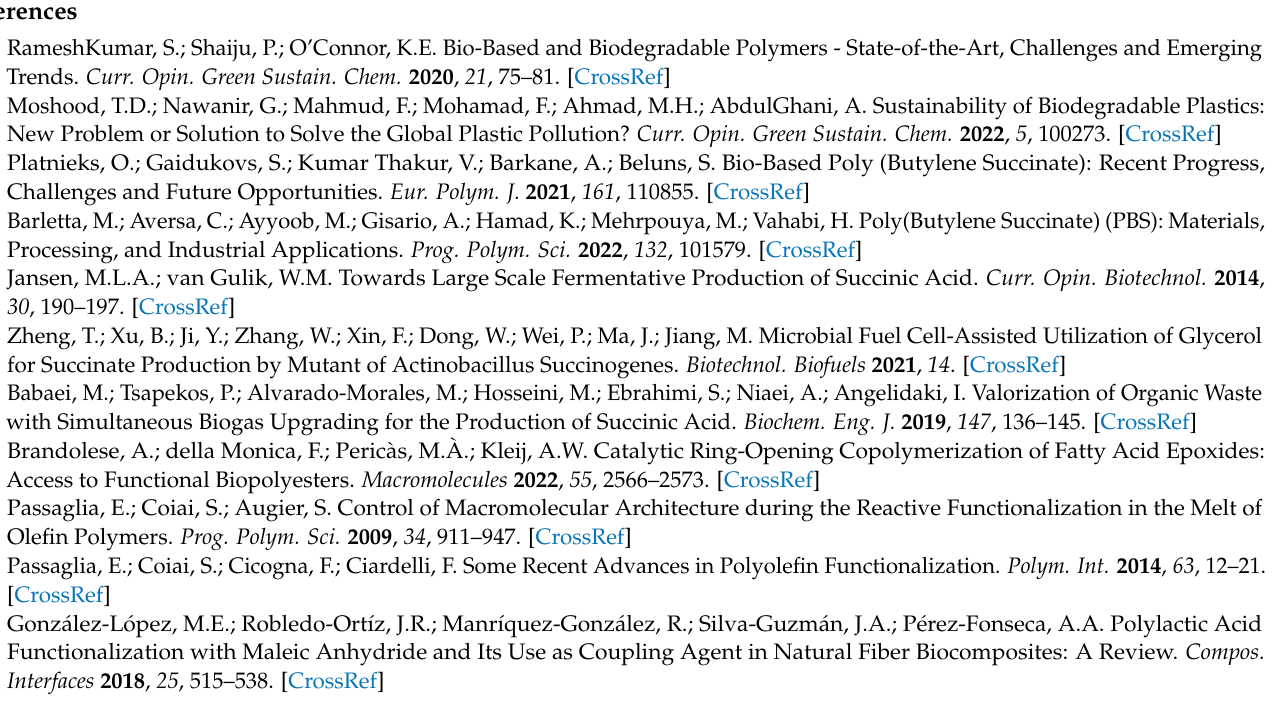
heating (a); crystallization first cooling (b); melting second heating (c), Figure S5: Overlay of SEC curves between 8 and 17 min of PBS (a) and PBS-g-(BHB-T)3 (b) after 0, 2, 4, 5, 6 and 7 h of oven aging. All chromatograms were normalized, Figure S6: Overlay of SEC curves between 8 and 16 min of PBS (a) and PBS-g-(BHB-T)3 (b) after 0, 0.5, and 6 h of UV irradiation. All chromatograms were normalized, Figure S7: Overlay of UV-Vis spectra of β -carotene solution (10 − 5 M) per different irradiation time (0: 0 min; 1: 10 min; 2: 20 min; 3: 30 min; 4: 40 min; 5: 60 min; 6: 90 min; 7: 140 min; 8: 190 min), Figure S8: Overlay of UV-Vis spectra of β -carotene solution (10 − 5 M) coated with PBS film per different irradiation time (0: 0 min; 1: 10 min; 2: 20 min; 3: 30 min; 4: 40 min; 5: 60 min; 6: 90 min; 7: 140 min; 8: 190 min), Figure S9: Overlay of UV-Vis spectra of β -carotene solution (10 − 5 M) coated with PBS-g-(BHB-T)3 film per different irradiation time (0: 0 min; 1: 10 min; 2: 20 min; 3: 30 min; 4: 40 min; 5: 60 min; 6: 90 min; 7: 140 min; 8: 190 min), Table S1: Number-average molecular weight (M n ), weight-average molecular weight (M w ), and dispersity (Ð) vs. of PBS and PBS-g-(BHB-T)3 vs. the thermo-oxidative aging time, Table S2: Number-average molecular weight (M n ), weight-average molecular weight (M w ), and dispersity (Ð) of PBS and PBS-g-(BHB-T)3 vs. the photo-oxidative aging